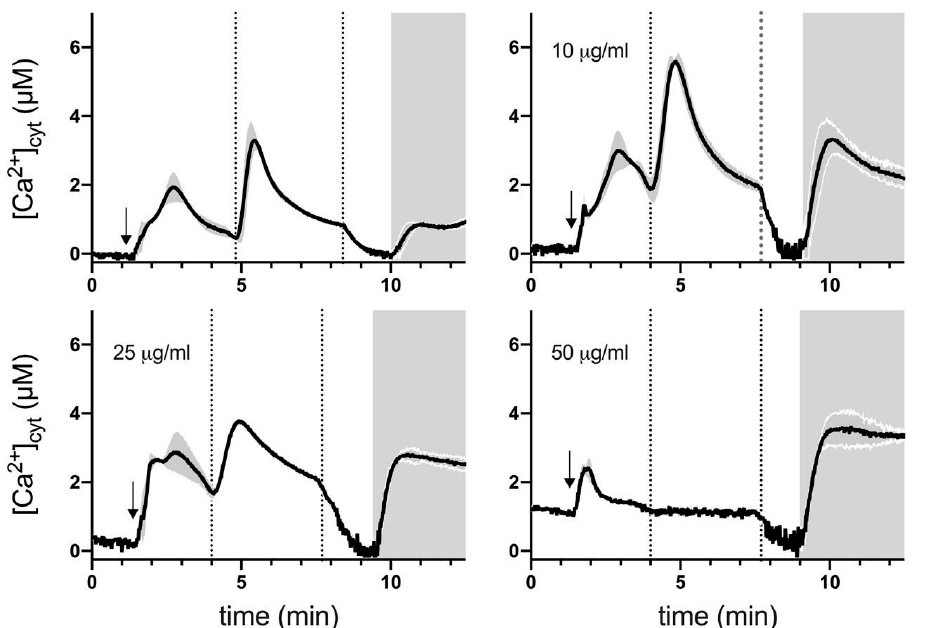
Figure 4. Effects of polygodial on yeast Ca 2+ homeostasis. Averaged Ca 2+ transient (grey shaded region either side of the Ca 2+ transient trajectory marks SEM, n = 3) of wild-type BY4741 yeast cells after 30 min pre-treatment with vehicle (DMSO) (upper left panel) or 10, 25, and 50 μ g/mL polygodial (as indicated). Cells were initially perfused with Ca 2+ -free starvation medium and then transferred to a 10 mM external Ca 2+ medium (indicated by arrow) followed by re-addition of 80 mM glucose (dashed vertical lines indicate perfusion with glucose that results in a TECC response). Thereafter, cells were briefly exposed to Ca 2+ -free medium prior to membrane permeabilization using Triton X-100 (grey shaded zone correlates with membrane permeabilization).